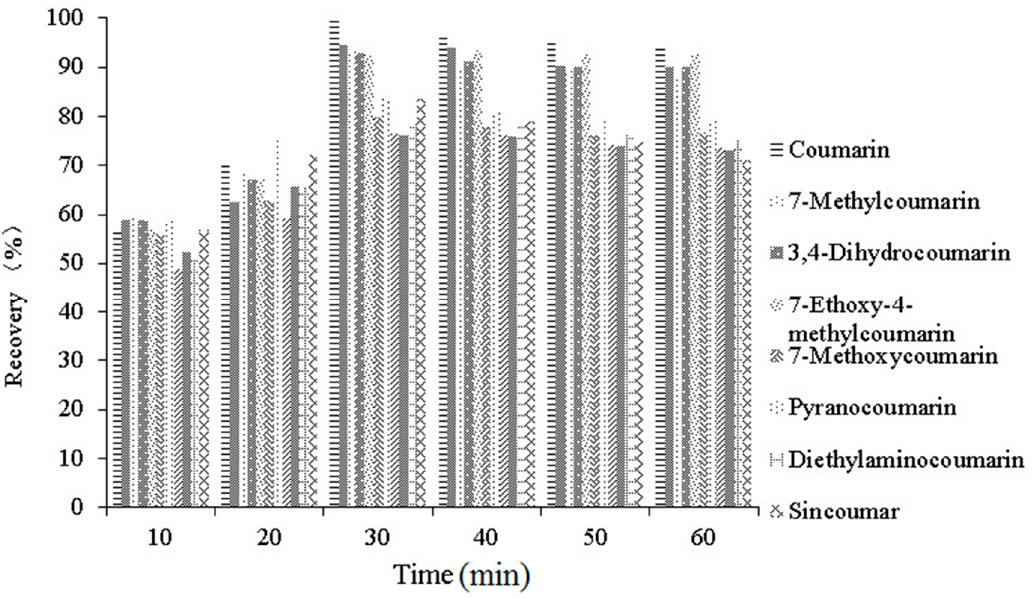
Figure 6. Select the extraction time (10, 20, 30, 40, 50, 60 min).